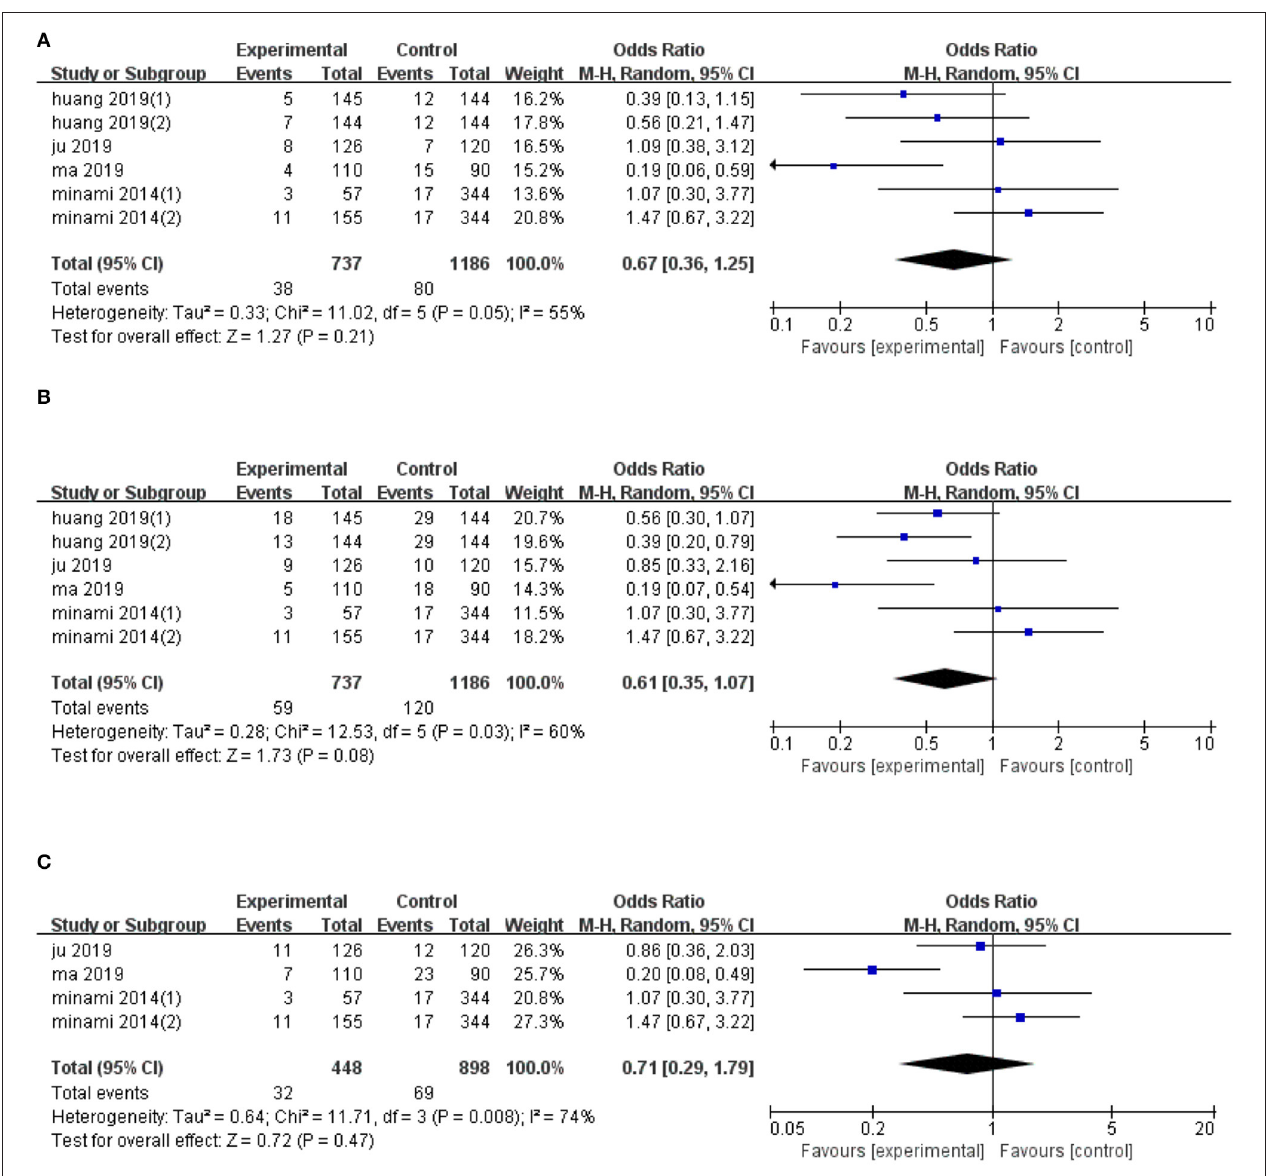
FIGURE 3 | Forest plot of the effects of ultrasonic image fusion on local tumor progression. (A) 1-year LTP, (B) 2-year LTP, and (C) 3-year